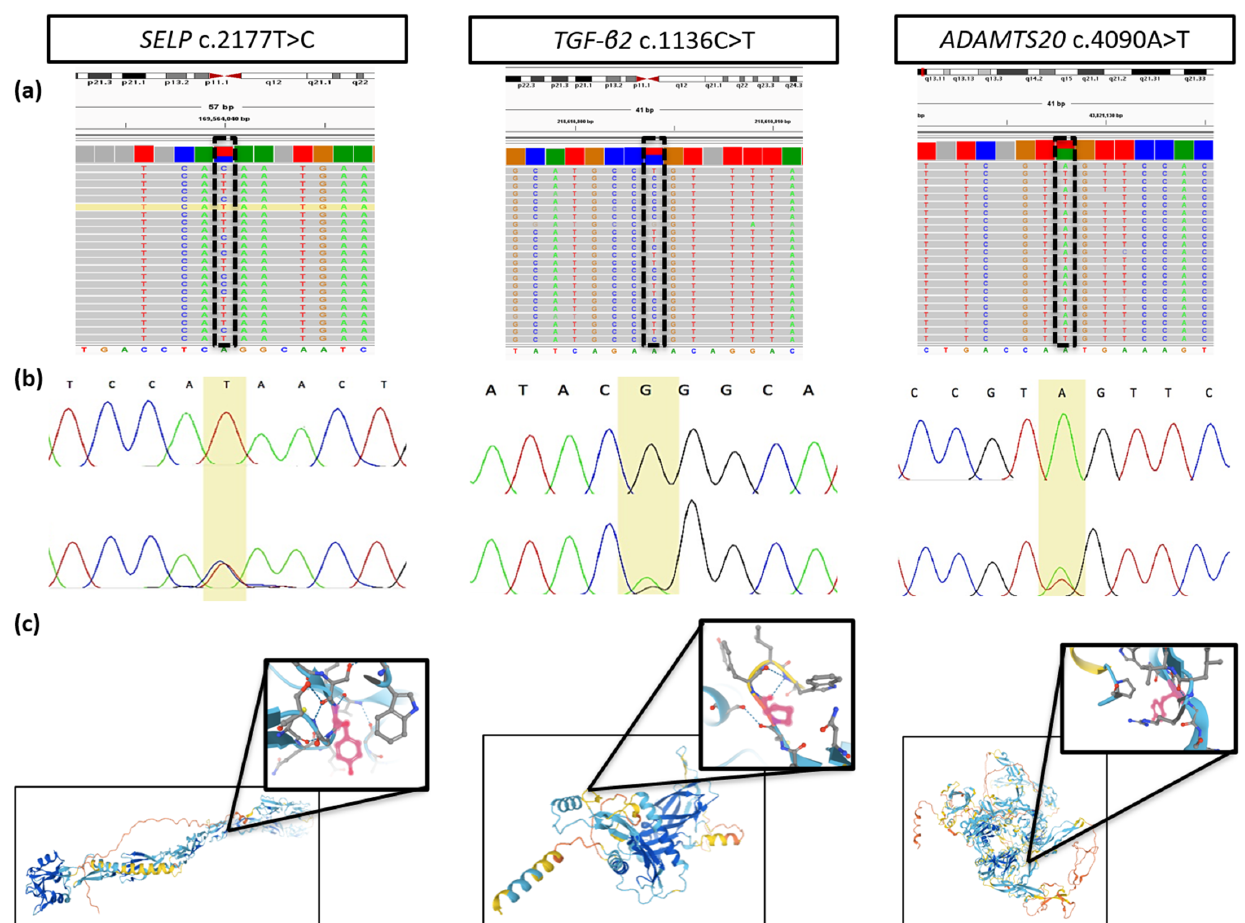
Figure 3. Validation of the shortlisted gene variants. ( a ) Excerpt of the BAM file uploaded in IGV showing the heterozygous change for all three variants, ( b ) Sanger sequencing traces showing a confirmed homozygous reference (top) and heterozygous (bottom) sequence for each of the three risk variants, ( c ) protein structure of P-selectin, TGF- β 2 and ADAMTS20 with a focus on the position of the variant within the protein according to AlphaFold Protein Structure Database [57,58] . Table 4. Genotype and allele frequencies of the three shortlisted variants in the MOFS collection.